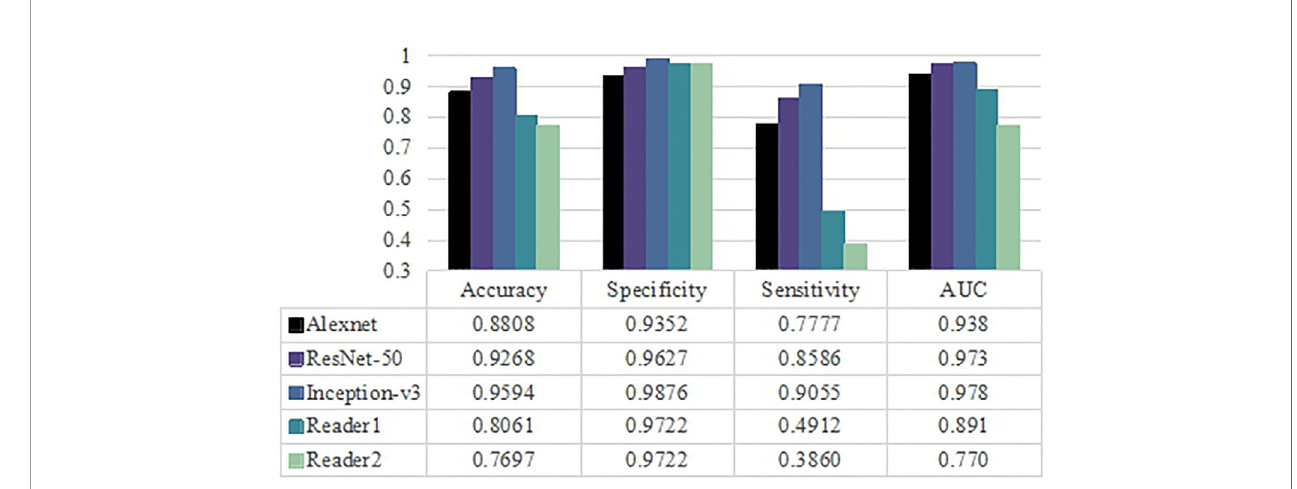
FIGURE 4 | Classi fi cation performance for three pretrained models and radiologists including averaged accuracy, speci fi city, sensitivity and AUC value as evaluation